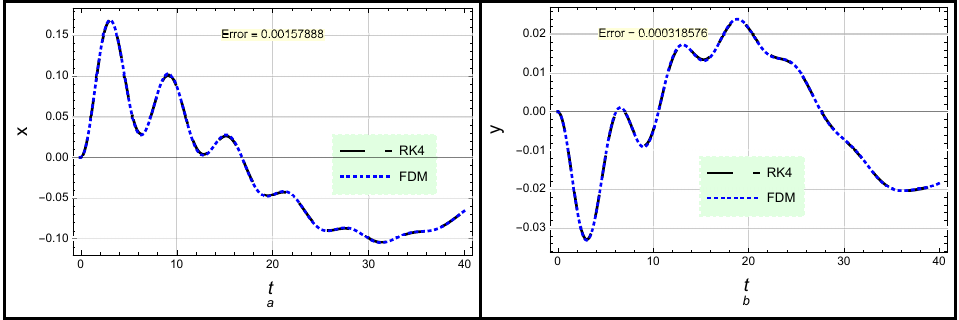
Fig. 3 Figure 3. The numerical approximations for ( a ) the real and ( b ) imaginary components ( x , y ) using the FDM are compared with the RK4 numerical